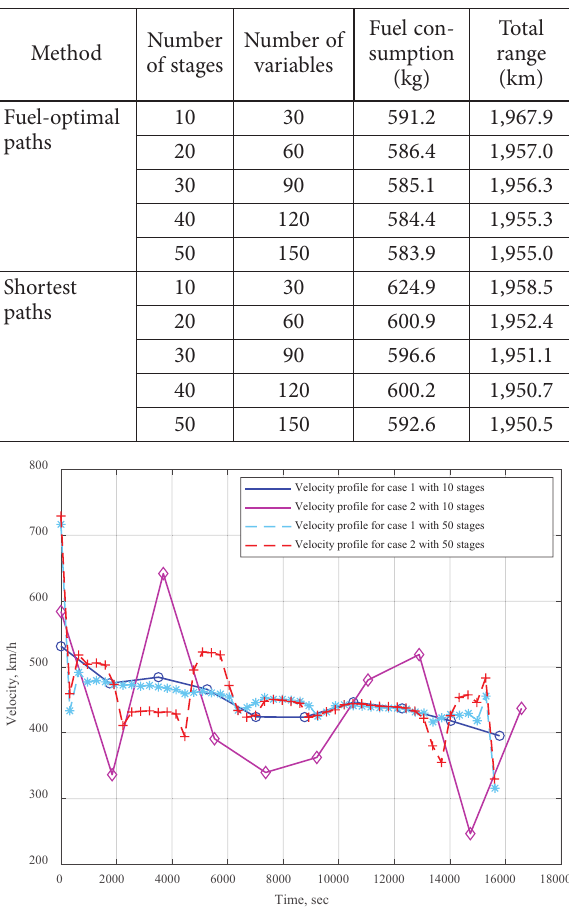
Figure 7. Optimal velocity profiles for four simulations in Figure 8. Fifty-stage optimal path comparison in scenario